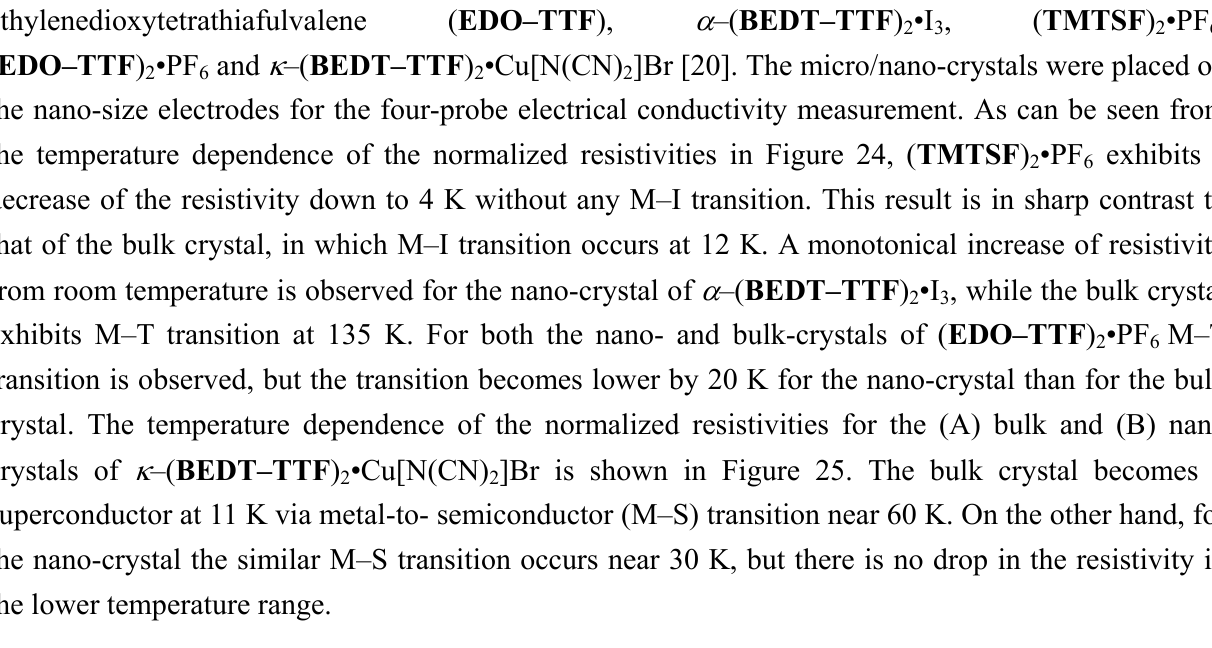
Figure 23. Temperature dependence of normalized resistivity for single crystal (A) and